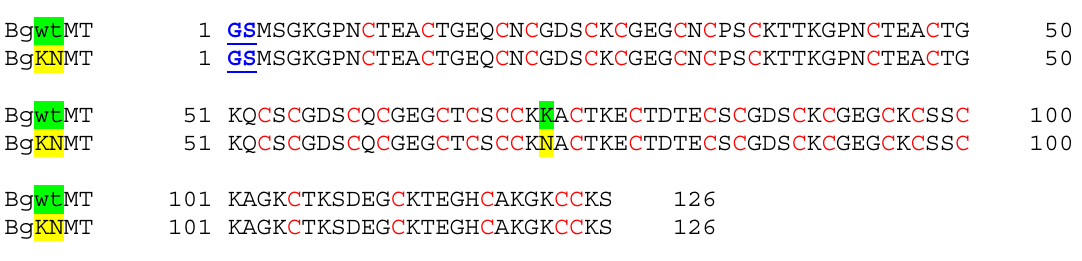
Figure 1. Amino acid sequences of the studied recombinant metallothioneins: Wild type (BgwtMT) and the naturally mutated (BgKNMT) proteins. Red : cysteine residues; underlined blue : N-terminal additional residues introduced due to the recombinant expression conditions (see material and methods section); shaded in green : wildtype position of K (BgwtMT); shaded in yellow : its replacement by N in the natural allelic mutant (BgNKMT). The two protein sequences can be found in the GenBank under the following accession numbers: KT697617 (BgwtMT); and KY963493 (BgKNMT).